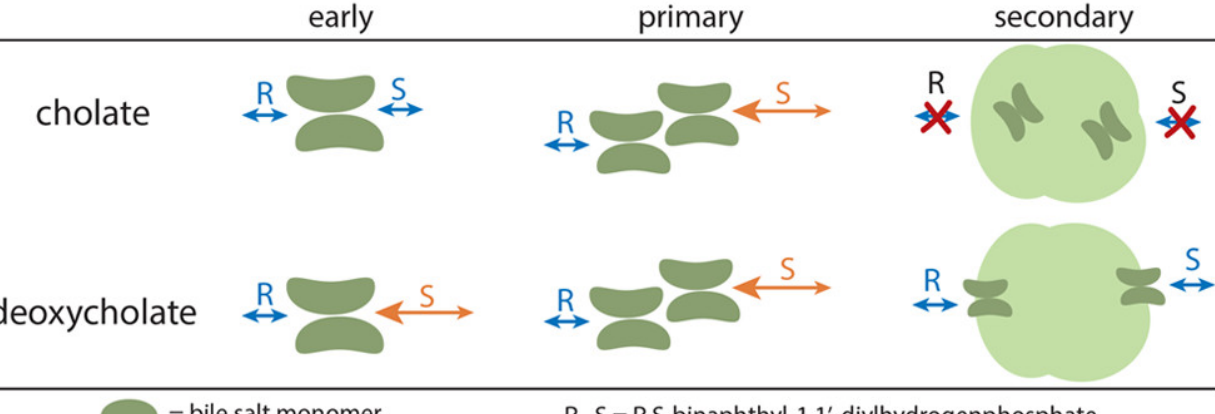
Figure 2. Schematic diagram of the aggregation behavior of bile salts using R,S -binaphthyl-1,1 ′ -diylhydrogenphosphate as probe. Bile salts aggregate stepwise into pre-micellar aggregates, primary and secondary micelles with increasing bile salt concentration. The S -isomer is preferentially bound in these bile micelles and enter through the 12 α -OH edge. Secondary micelles of sodium cholate and deoxycholate are non-enantioselective yet have different binding surface structures. Reprinted with permission from [17], © 2021 American Chemical Society.